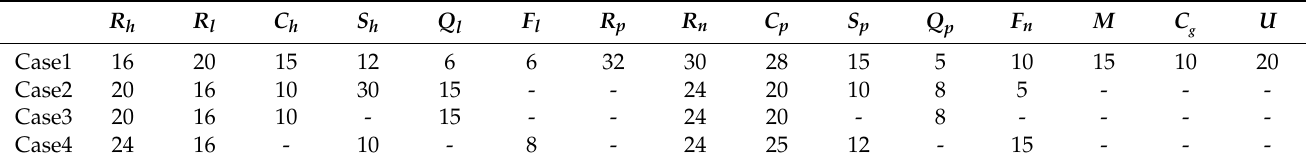
Table 4. Simulation values in four cases.